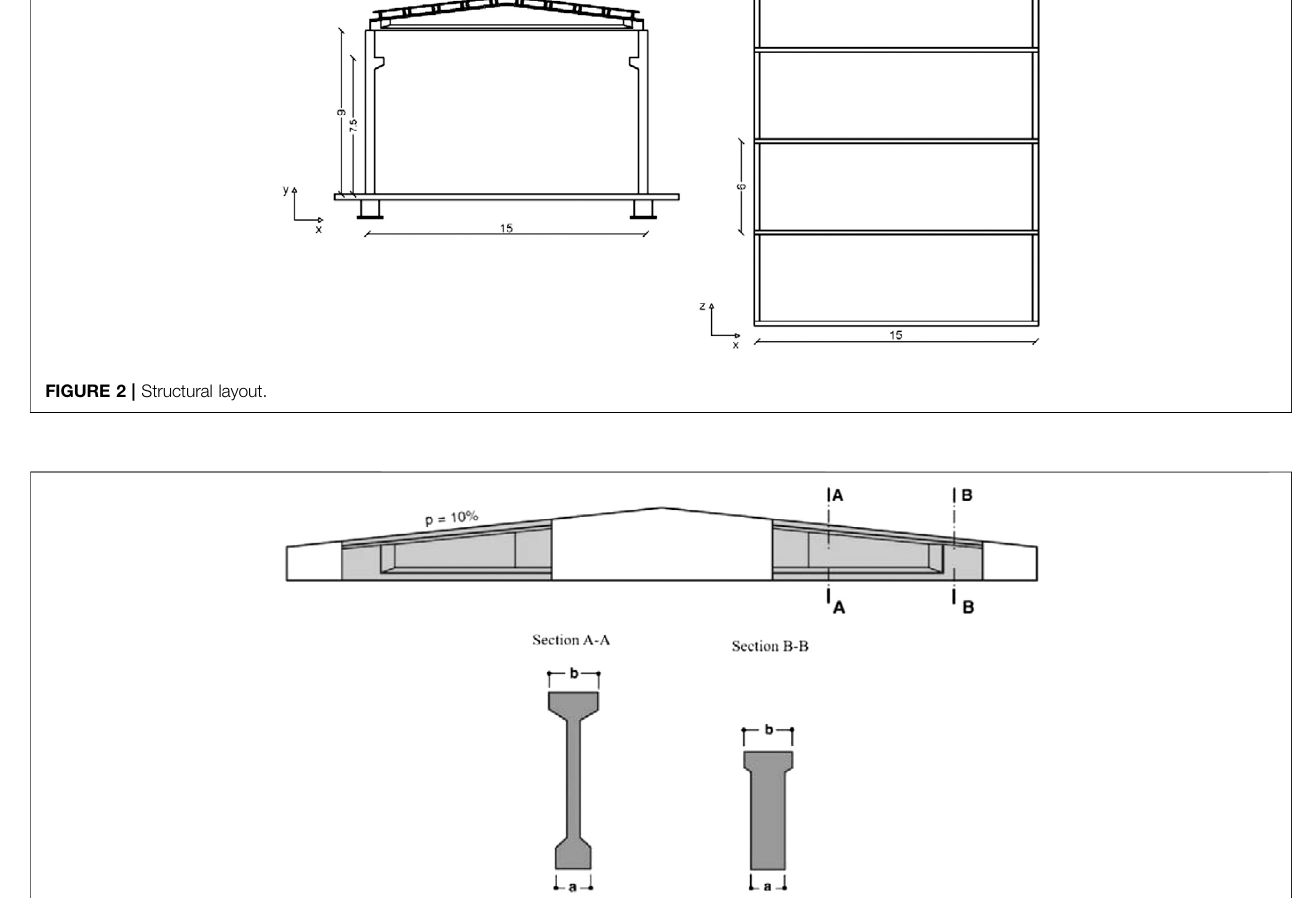
FIGURE 3 | Main beam con fi